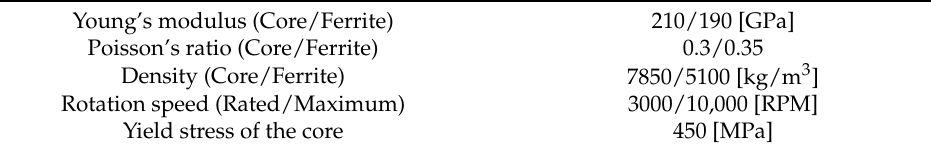
Figure 8. Von Mises stress analysis result of the optimum model ( a ) At rated speed; ( b ) At maximum speed. Table 5. Parameters for the mechanical stress